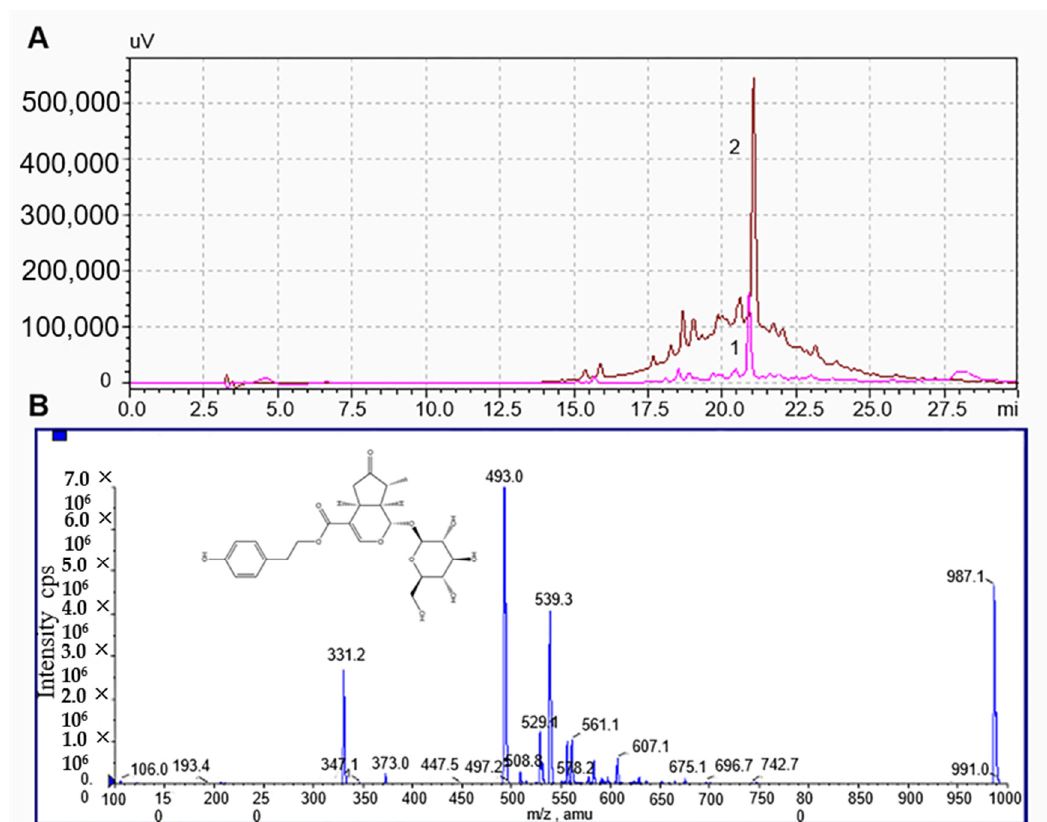
Figure 5. Liquid chromatography of syringopicroside standard (Line 1) and purified sample (Line 2) ( A ) and mass spectra of a purified sample ( B ).